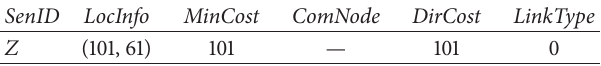
Table 1: Vicinity table (node 𝑋 ) after receiving message from 𝑍 .